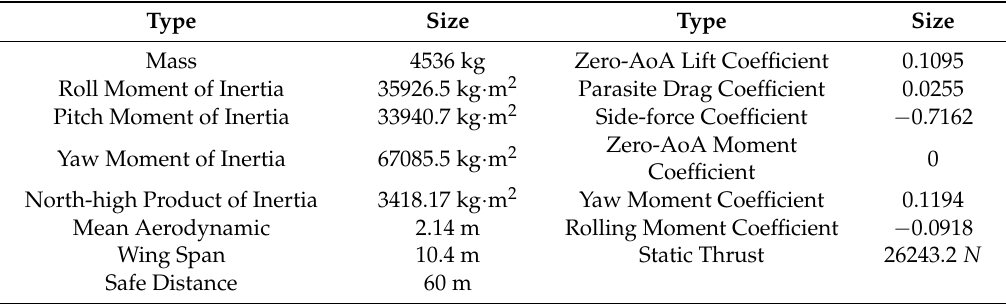
Table 2. Attribute list of Unmanned Aerial Vehicles